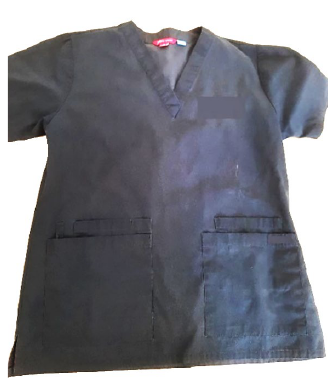
Nozzles placed at corners and point towards center